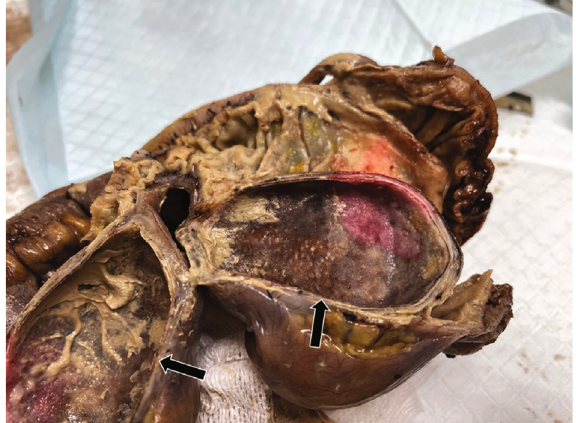
Figure 3: Surgical resection showing the cecal replication cyst after formaldehyde fi